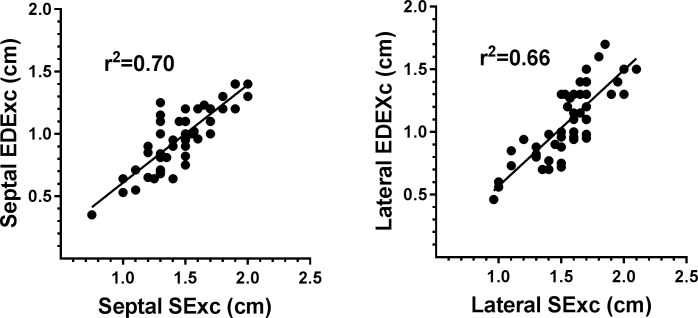
Scatter plots showing the relationships of EDExc with SExc for the septal and lateral walls.